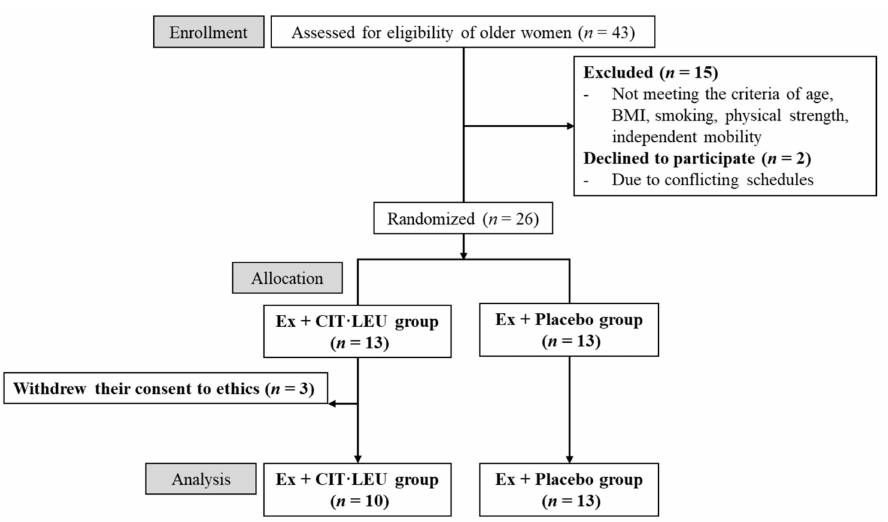
Figure 1. Flow-chart